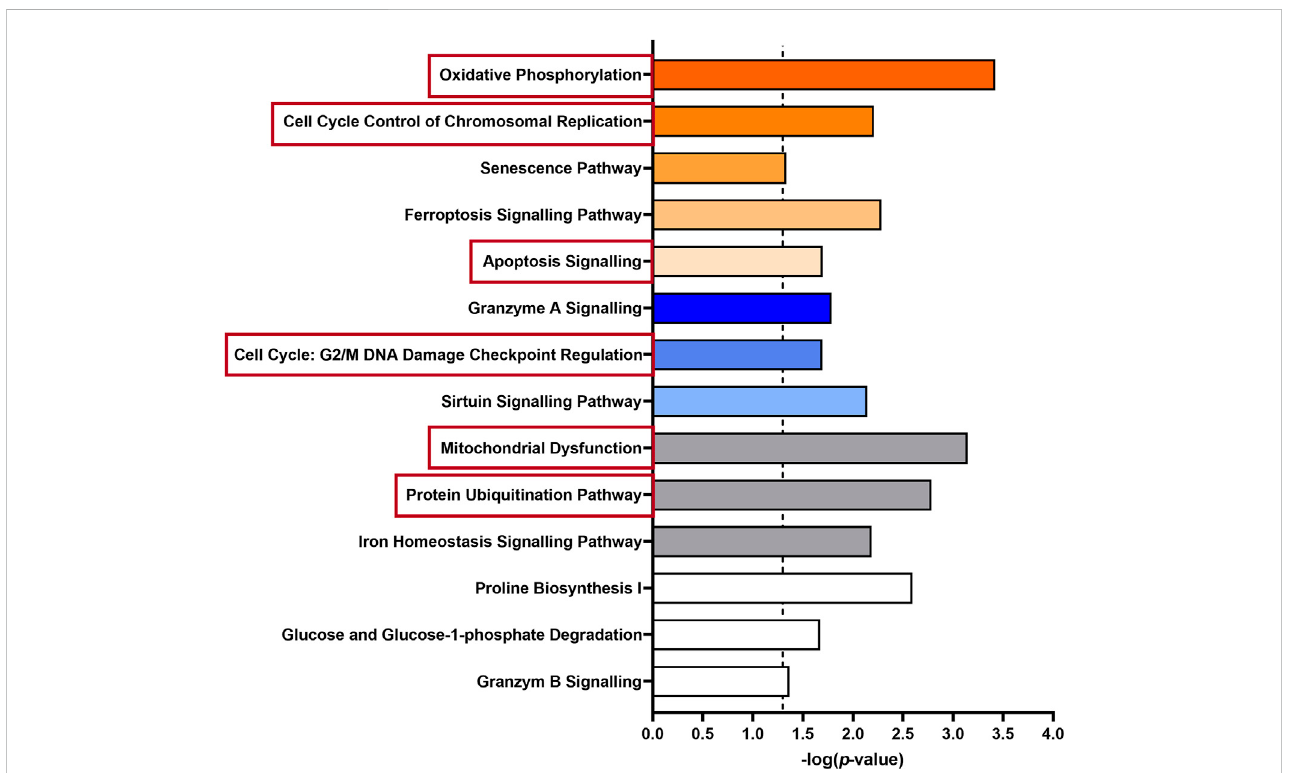
FIGURE 3 Enriched pathways of 456 differentially expressed genes in untreated or PA + HK4-treated HepG2 cells compared to PA-treated cells. The length of the barsisproportional to thesigni fi cance oftheassociationbetweenthesetofgenesand thepathway, expressedbythenegative logarithm ofthe p -value. Only pathways with p ≤ 0.05(dottedthresholdline)are shown. Upregulatedpathways inuntreated orPA +HK4-treatedcells associated withapositive z-score are coloredinorange,downregulatedpathwaywithanegativez-scoreareshowninblueandpathwayswithnochangeoranunknownpatternaremarkedin white or grey. Selected canonical pathways which are subsequently considered in more detail are highlighted in